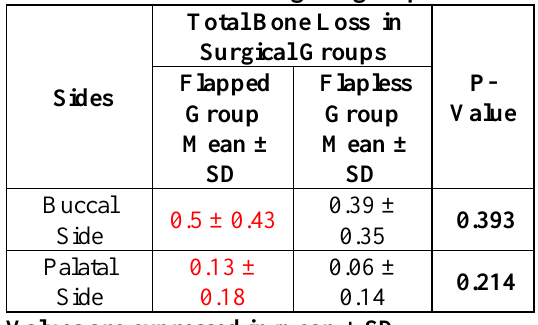
Table 1: Comparison according to total mean bone loss in buccal and palatal sides between two surgical groups.